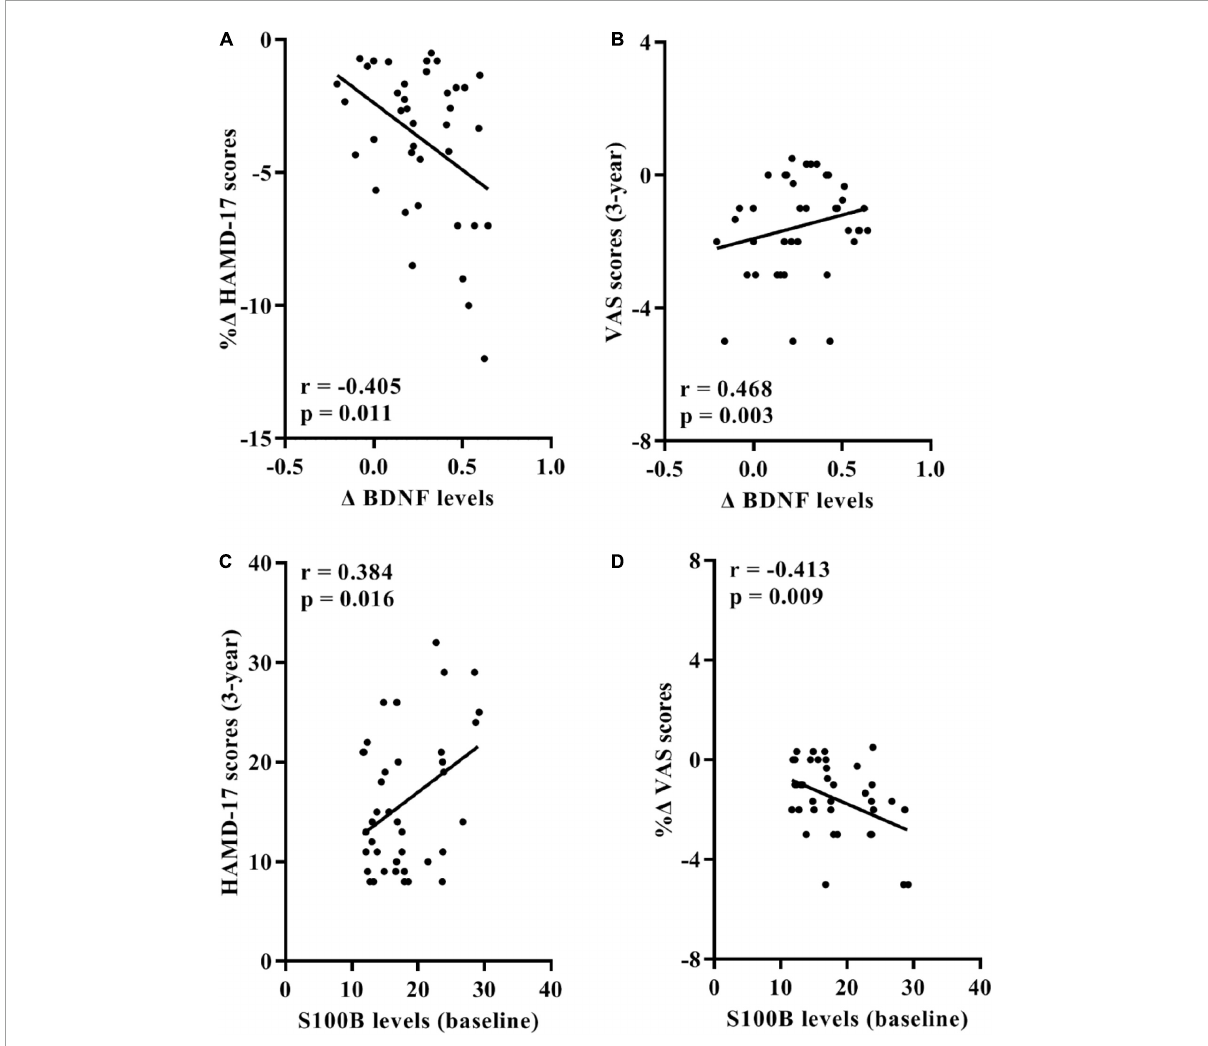
FIGURE3 Associations between serum BDNF/S100B levels and the HAMD-24 and VAS scores in 39 participants of trans-MDD group after the 3-year follow-up. (A) Correlation between rates of change of HAMD-17 scores and the change value of BDNF levels. (B) Correlation between the change value of BDNF levels and the VAS scores at the conclusion of the 3-year follow-up. (C) Correlation between the HAMD-17 scores at the end of the 3-year follow-up and serum S100B levels at baseline. (D) Correlation between rates of change of VAS scores and serum S100B levels at baseline. BDNF, brain-derived neurotrophic factor; HAMD-17, 17-item Hamilton Depression Scale; VAS, Visual Analogue Scale; OA, osteoarthritis; MDD, major depressive